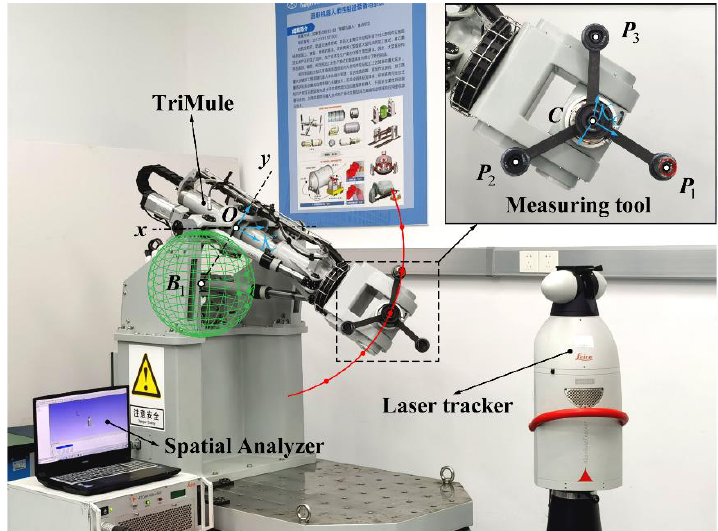
Figure 7. Experimental setup for the calibration of the TriMule robot.